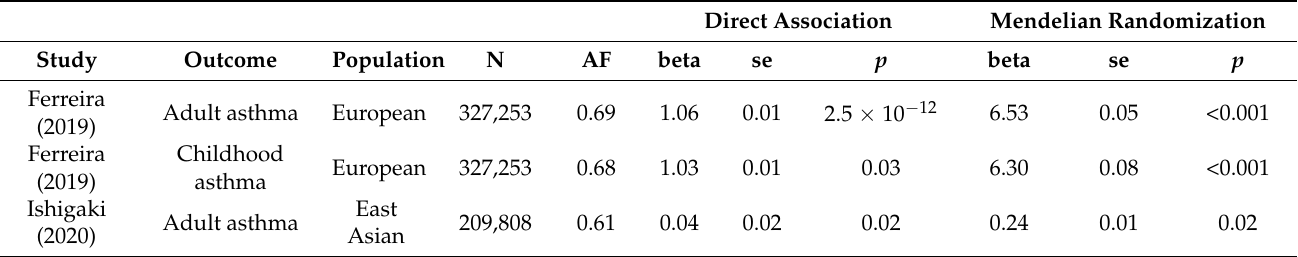
Table 4. The association between rs28456 and asthma from observational studies and Mendelian Randomization analysis. Direct Association Mendelian